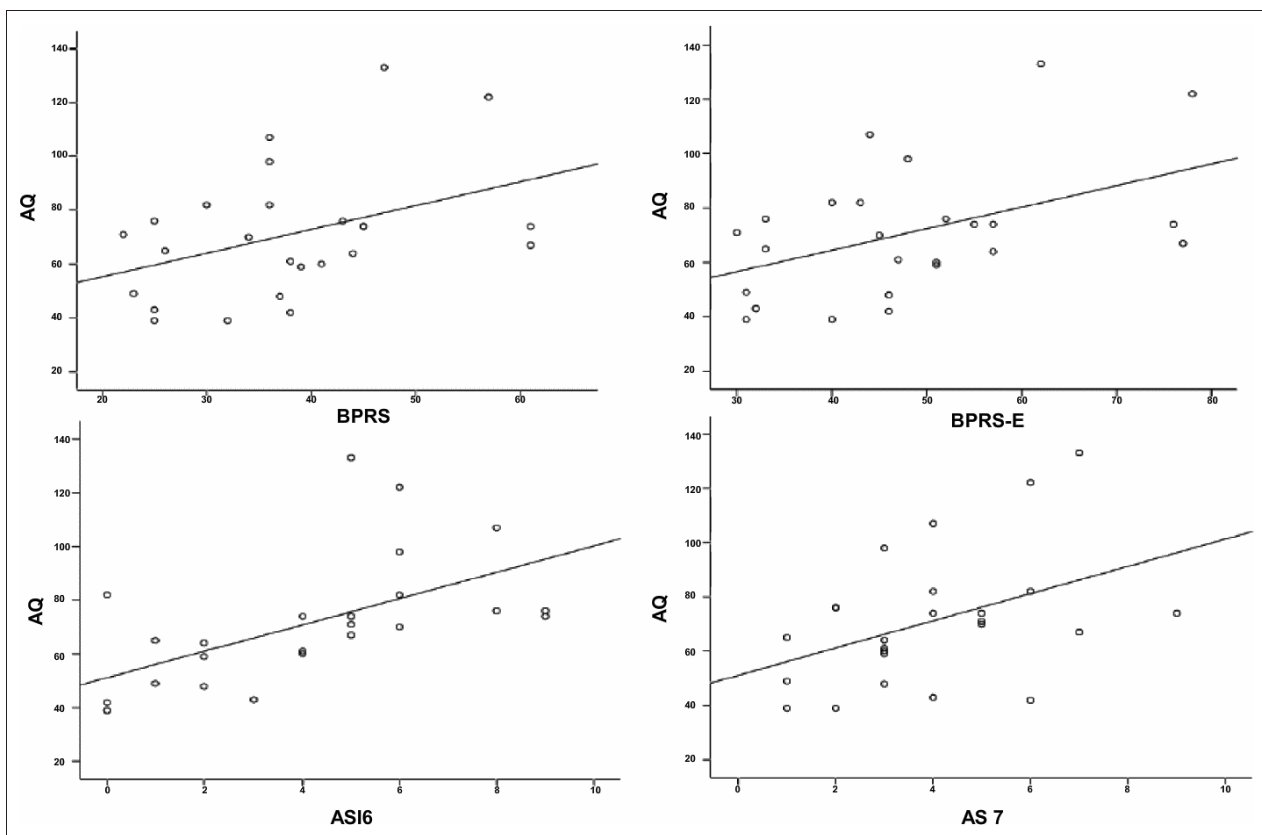
FigurE 1 | relationships between aggression questionnaire (AQ) and brief psychiatric rating scale (BPrS), expanded BPrS (BPrS-E), addiction severity index 6 (ASi 6), ASi 7, in the 25 alcoholic patients at baseline. Significant